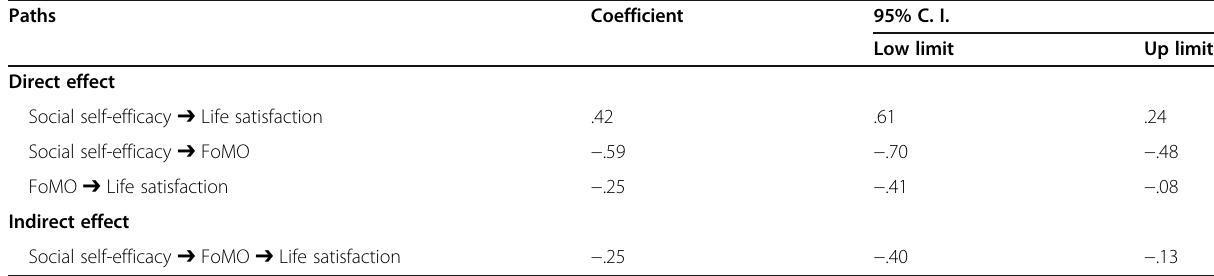
Table 3 Indirect effect of social self-efficacy on life satisfaction via FoMO